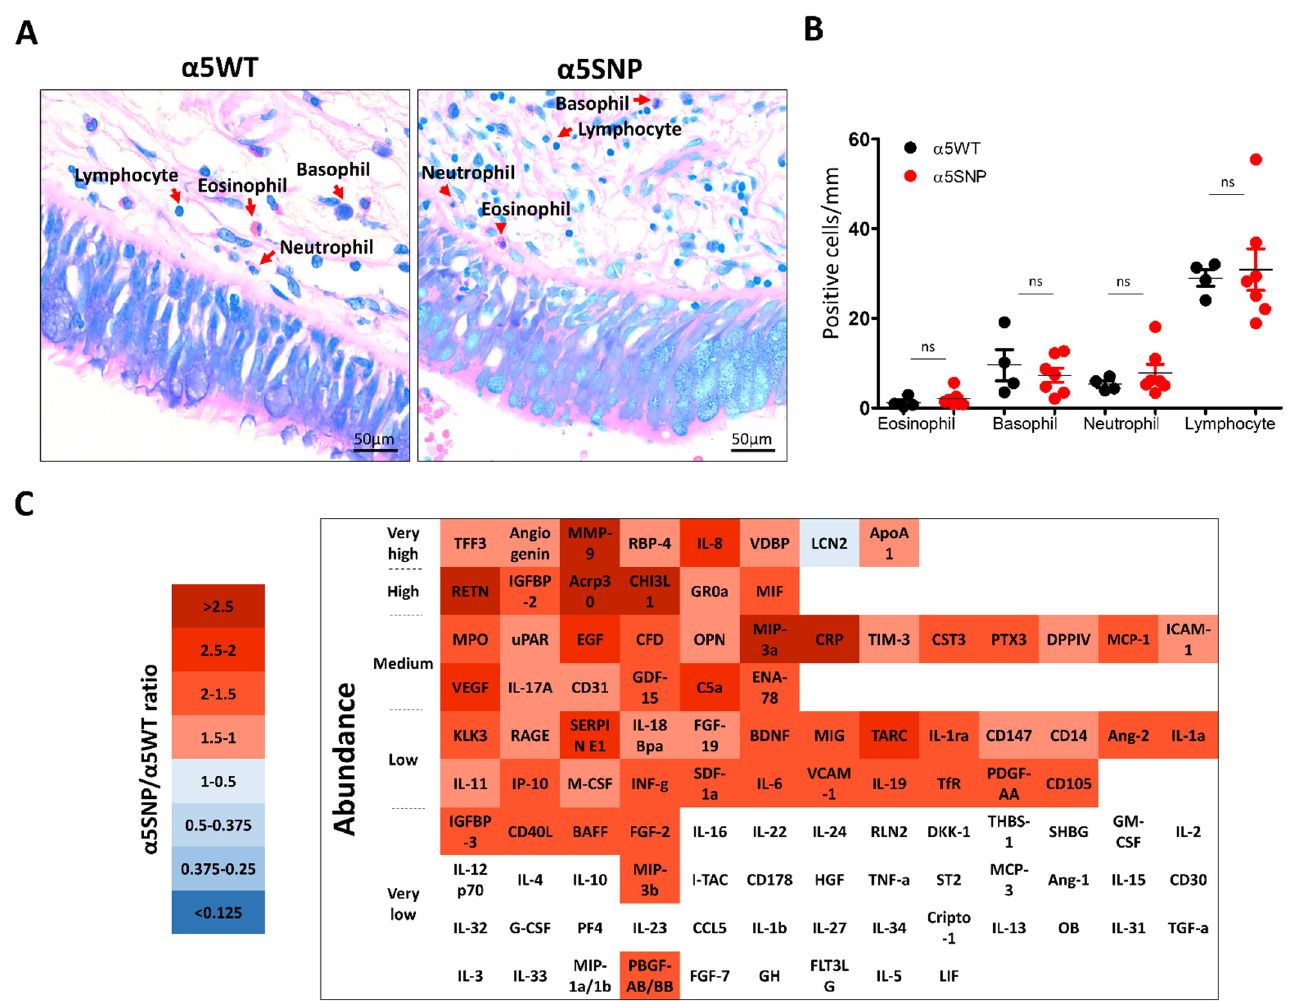
Figure 3. Lung inflammatory response in rs16969968 ( α 5SNP) COPD patients. ( A ): Microscopic acquisitions showing peribronchial recruitment of immune populations in α 5SNP and α 5WT COPD patients. ( B ): Dot plot showing the number of eosinophils, basophils, neutrophils, and lymphocytes per mm of epithelium in α 5SNP vs. α 5WT COPD patients. ( C ): Heatmap presenting the ratios of inflammatory mediators’ expression in broncho-alveolar lavage fluids of α 5SNP vs. α 5WT COPD patients. Downregulated inflammatory mediators are presented in blue, and upregulated ones are in red. The inflammatory mediators whose expression is lower than the detection cut-off value (5% of positive control) are identified in white. The inflammatory mediators are categorized according to their detected abundance in the broncho-alveolar lavage fluids of COPD patients (from very high, >50% of the detection of the positive control; to very low, <5% of the detection of the positive control). ns,